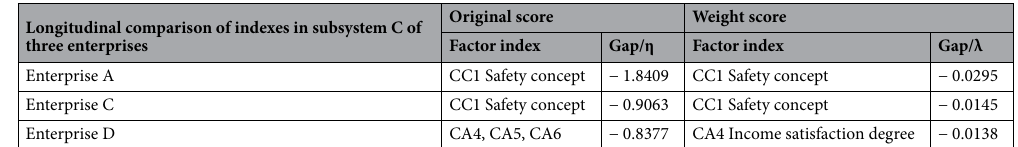
Table 21. Analysis of the shortcomings of the basic index scores of front-line workers’ safety status (subsystem C) in three companies—horizontal comparison.